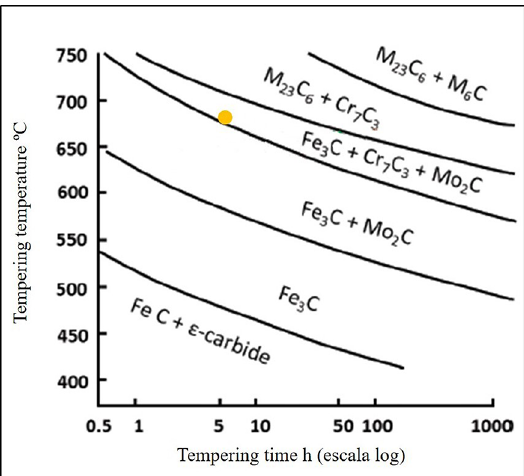
Figure 4. Formation of carbides in ASTM A182 F22 steel, with respect to temperature and time applied in the PWHT 29. quoted in the literature in works employing the GMAW welding process for low alloy steel-Alloy 625. Dodge et al. 22 associate the presence of Fe in the zone Φ with the fact that the greatest composition changes occur in regions of planar solidification compared to the cellular dendritic areas (Π).